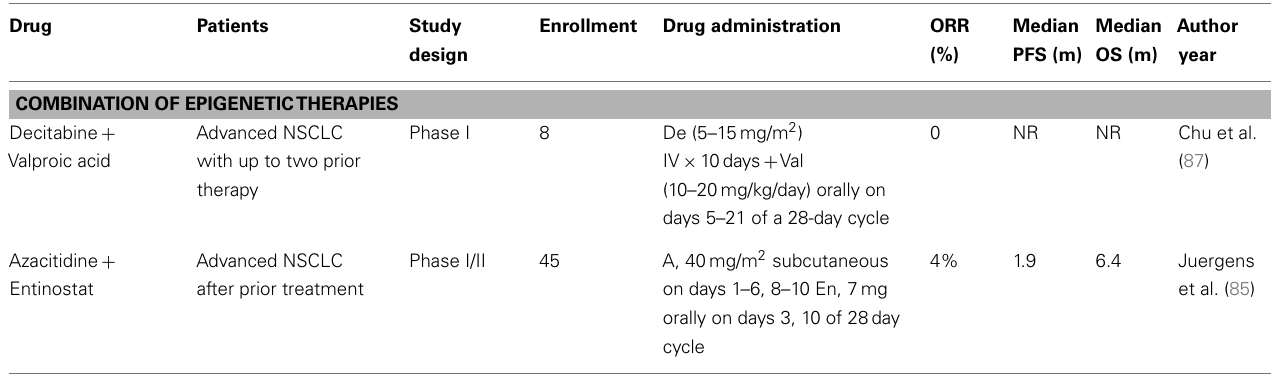
concentrations for growth inhibition (Luchenko et al., manuscript in preparation).The NSCLC cell line responds to the HDAC inhibitor with G2 arrest and loss of the G1 peak, while the SCLC line H526 responds with both G1 and G2 arrests and